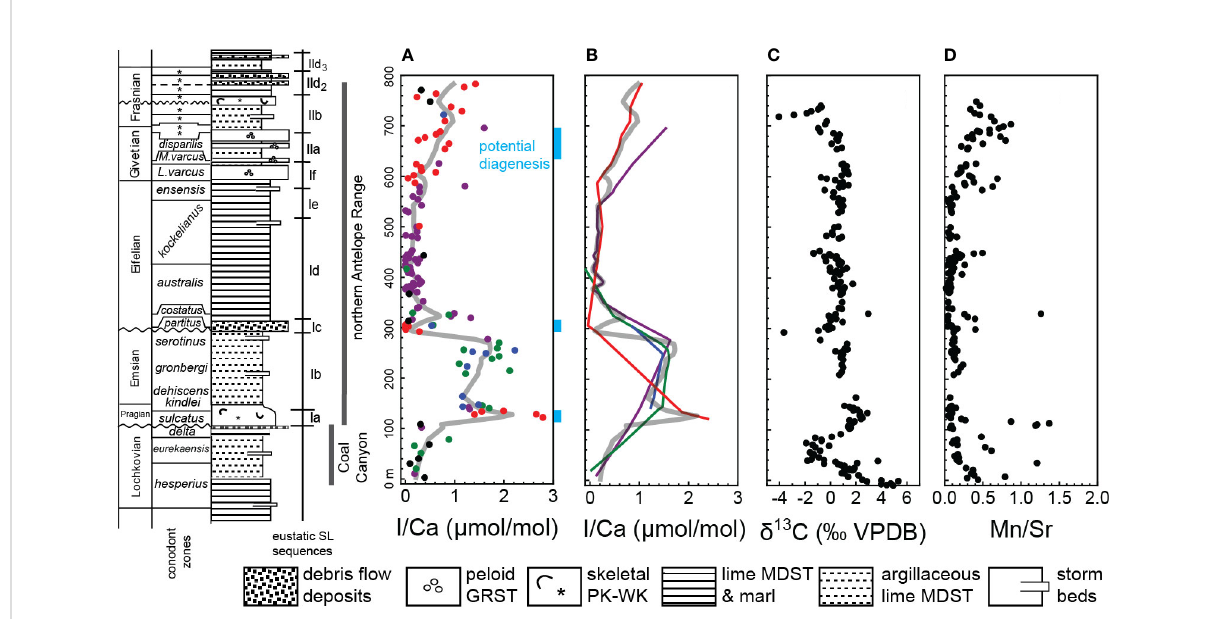
FIGURE 3 Geochemical measurements of the Great Basin composite section: (A) carbonate lithology-speci fi c I/Ca ratio, (B) LOWESS smoothing trends for four lithologic facies, (C) bulk carbonate carbon isotopes, (D) Mn/Sr ratios. Color code for lithological groups: grainstone (red), packstone (blue), wackestone (green), lime mudstone (purple), unassigned (black). The thicker gray lines in (A, B) show the LOWESS smoothing results of all the samples, while other colored lines represent the LOWESS smoothing for each lithological group (with the same color code as the dots). GRST, grainstone; PK, packstone, WK, wackestone; MDST, mudstone, SL, sea level. Blue lines in (A) represent intervals that may record potential diagenetic alteration. *Conodont zones not labelled are (in ascending order): norrisi, MN 1-2, MN 3, MN 6, hassi-jamieae, l. rhenana, u. rhenana, linguiformis